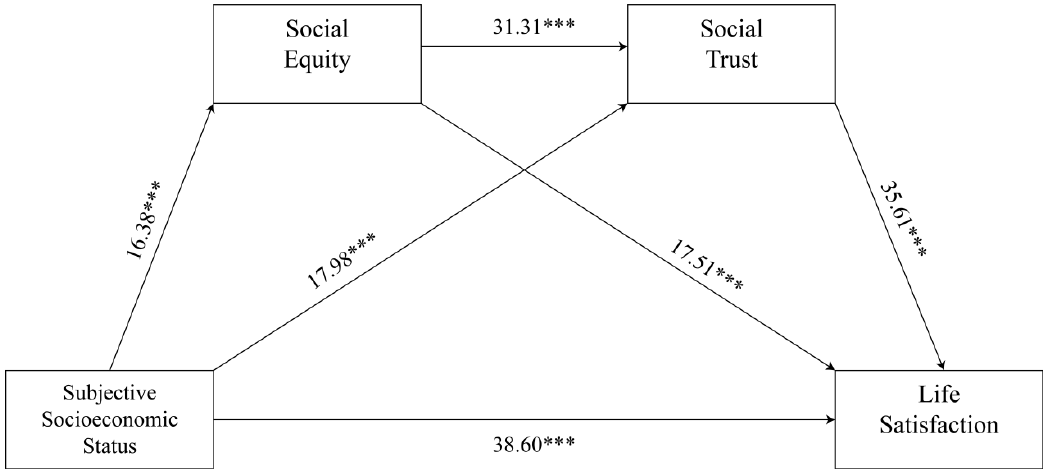
Figure 2. The pathway coefficients of multiple mediation models. *** p < 0.001. Table 3. Regression analysis of the mediation model of social equity and social trust between subjective socioeconomic status and life